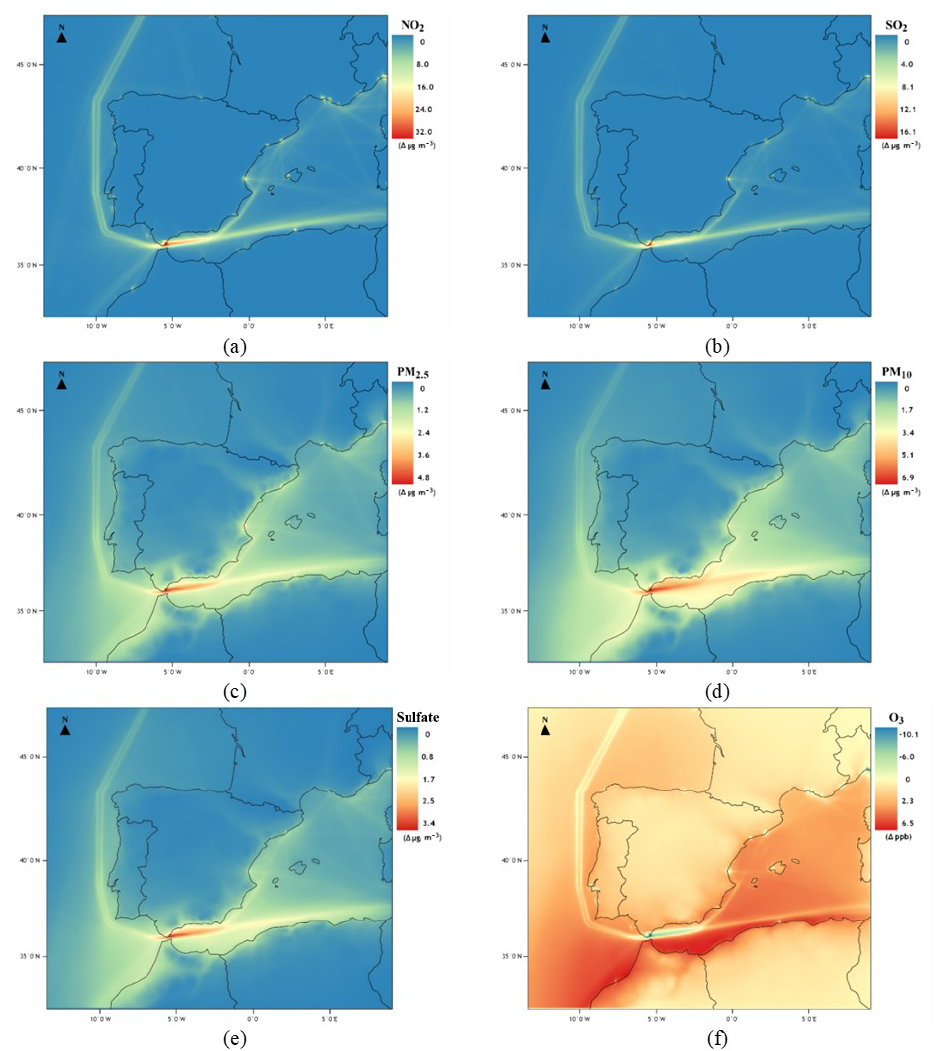
Figure 3. Contribution of shipping emissions to annual mean surface concentrations of (a) NO 2 , (b) SO 2 , (c) PM 2 . 5 , (d) PM 10 , (e) sulfate, and (f) O 3 in the study domain in 2015 ( (cid:49) = S-SCN –